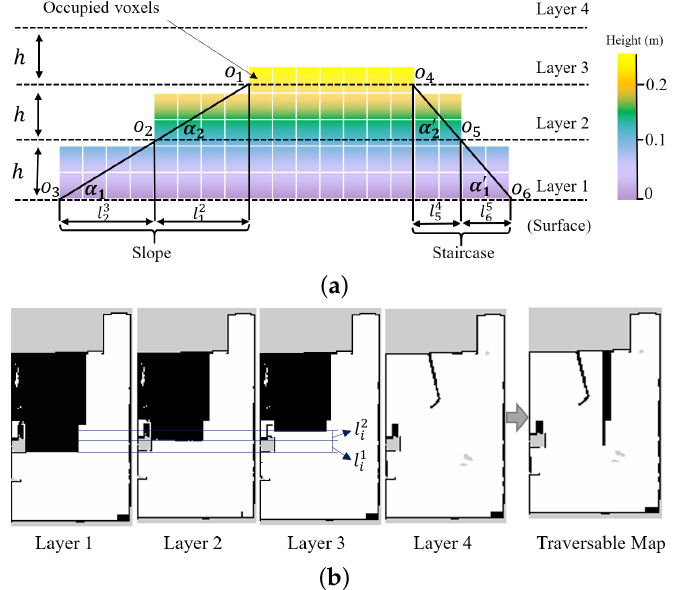
Figure 4. The schematic diagram of traversable map generation in a simulation environment. ( a ) occupied voxels representation of the slope and staircase. The colorful voxels represent the Octomap of the environment. ( b ) In the traversable map, the slope is marked as the collision-free area ( white area ) except the slope edge, while the staircase is marked as the occupied area ( black area